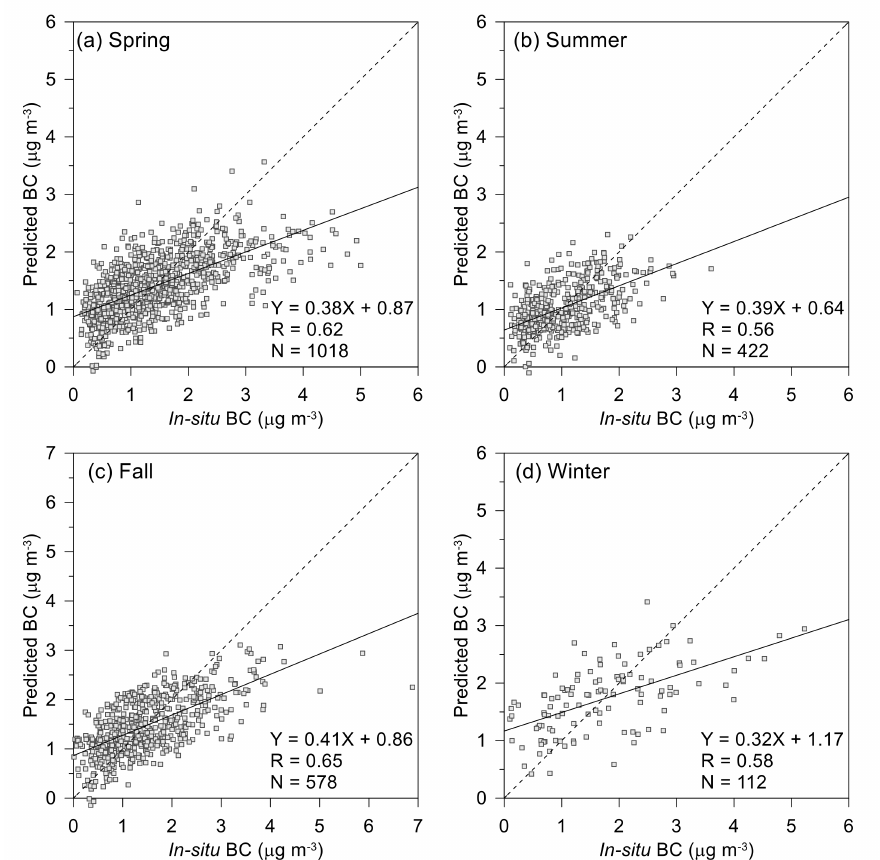
Figure 6. Seasonal scatter plots between the predicted BC from the multiple linear regression (MLR) model and measured in-situ BC concentrations during ( a ) spring, ( b ) summer, ( c ) fall, and ( d )